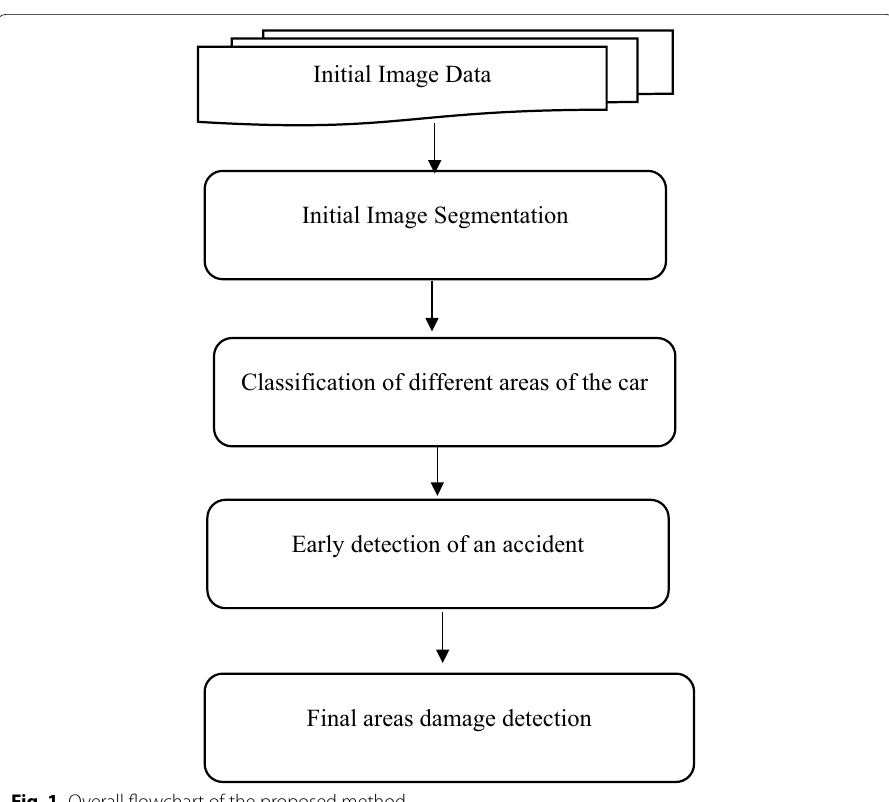
Fig. 1 Overall flowchart of the proposed